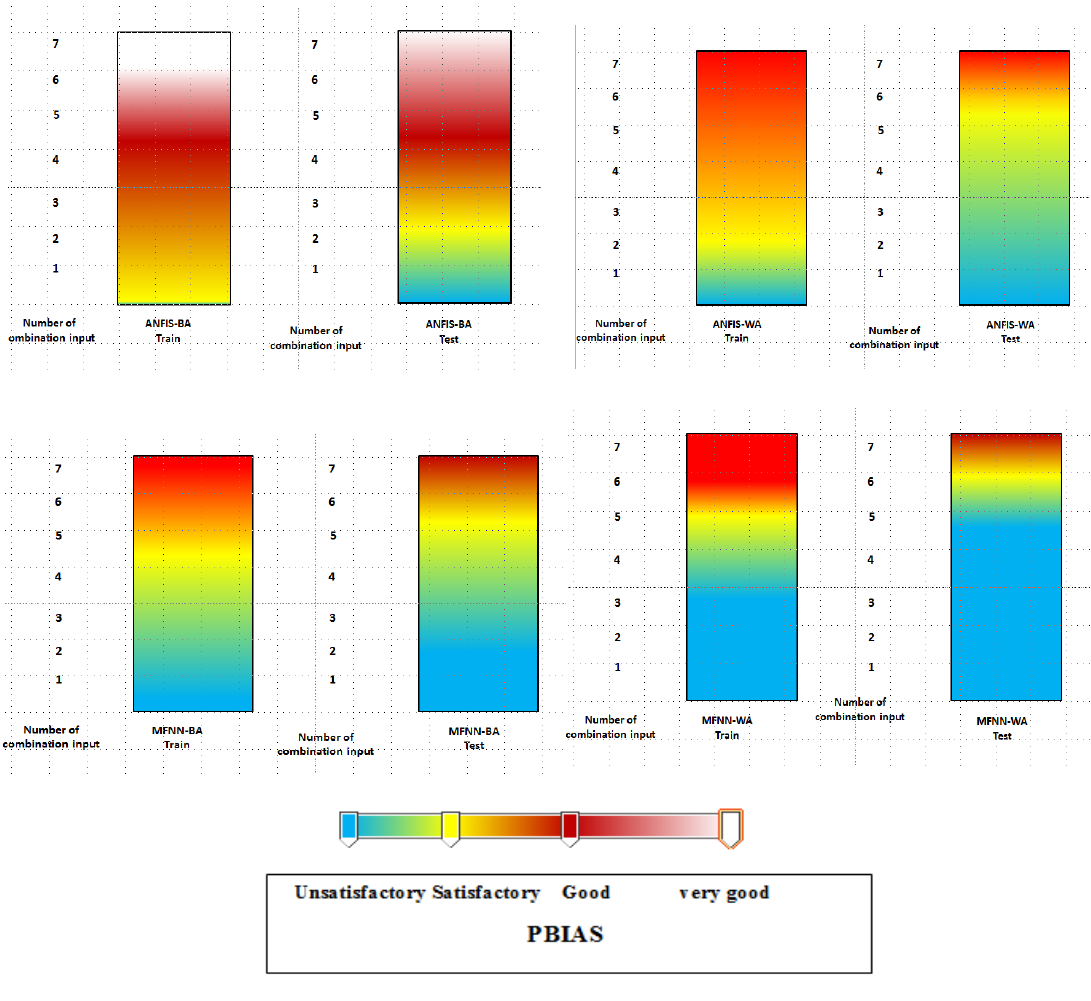
Figure 12. Computation of percent bias